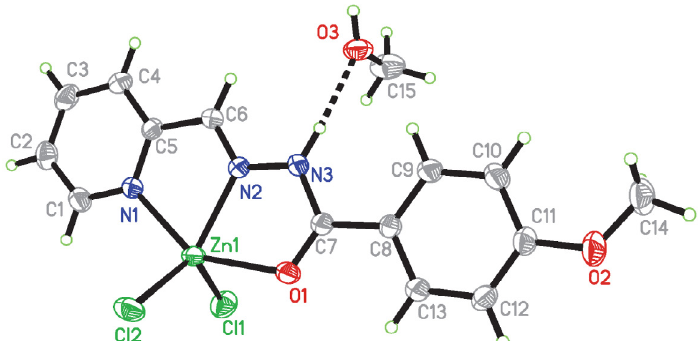
Figure 5. Molecular structure of 2 , showing the atom-numbering scheme. Displacement ellipsoids for non-hydrogen atoms are drawn at 30% prob- ability level.